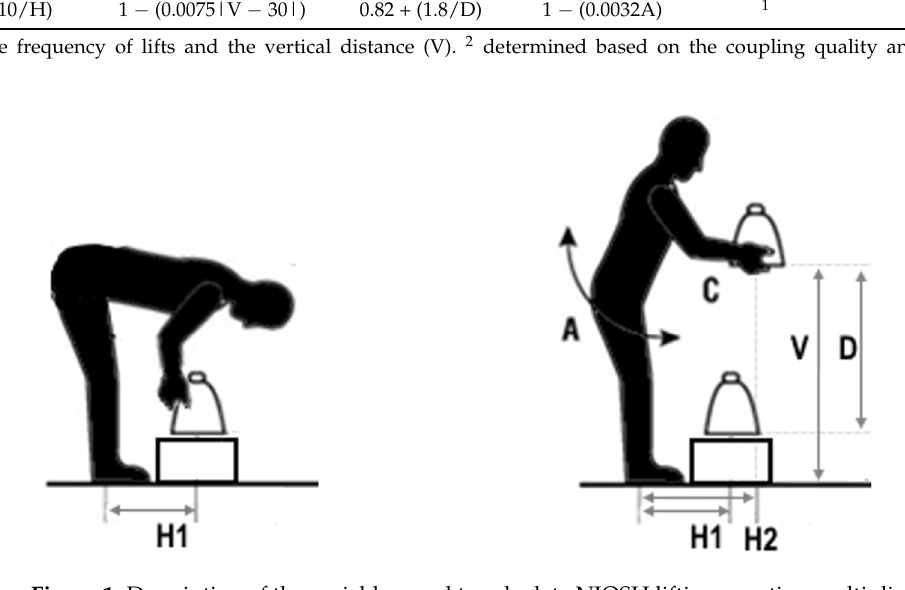
Figure 1. Description of the variables used to calculate NIOSH lifting equation